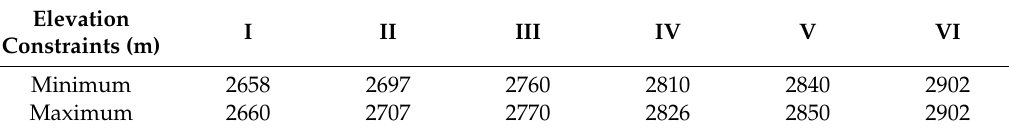
Table 4. Stages elevation